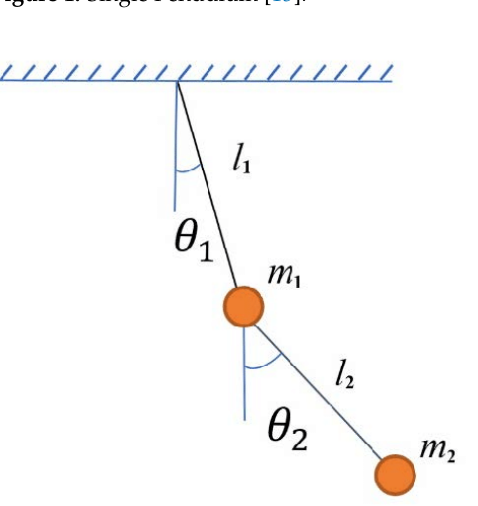
Figure 1. Single Pendulum [15].